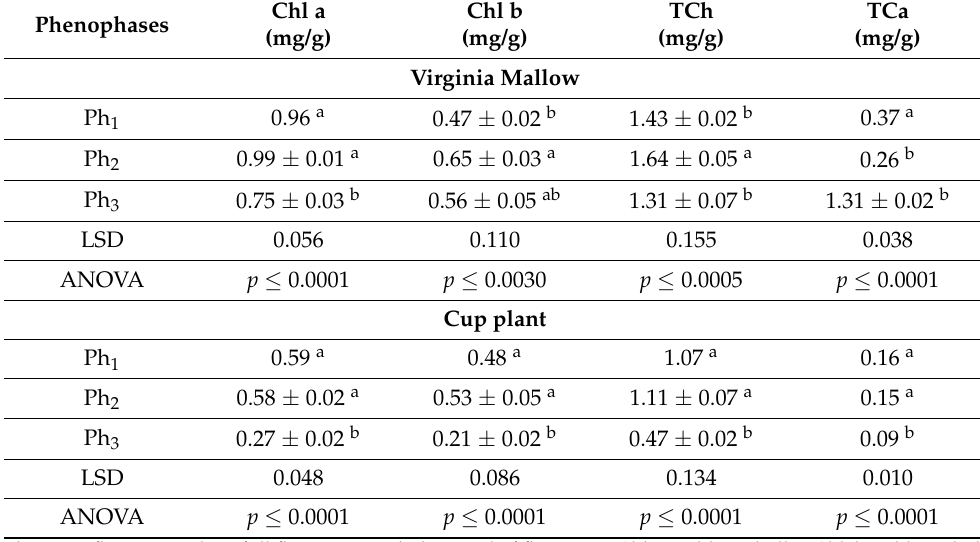
Pigment compounds content of Virginia mallow and cup plant leaves in differ- ent